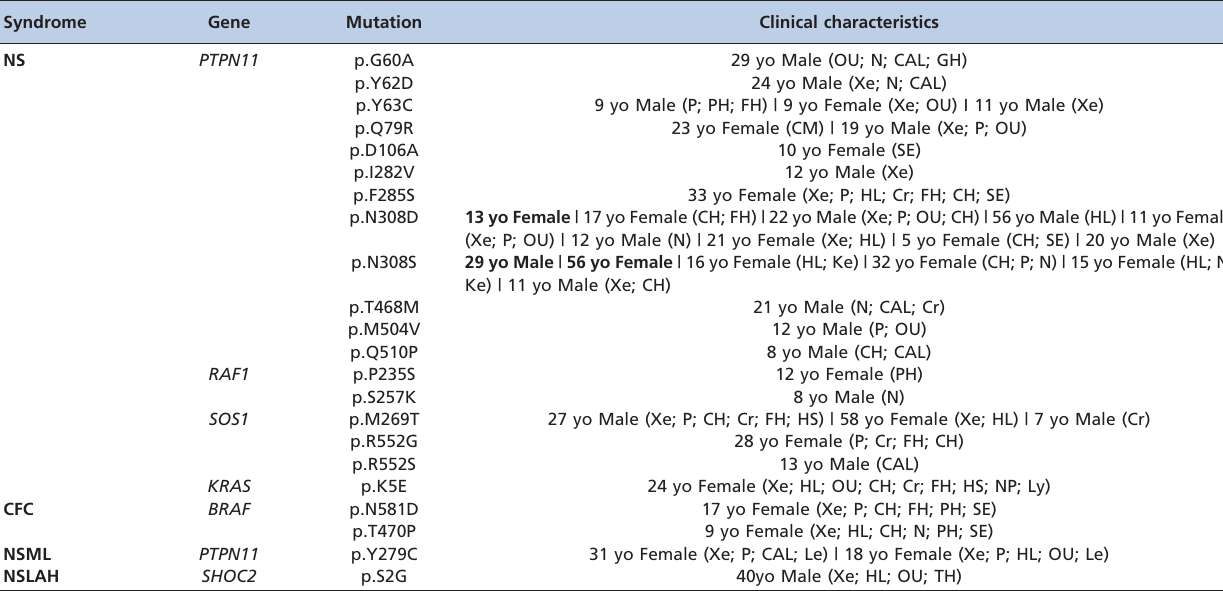
Table 1 - Genetic and clinical profiles of the 41 patients diagnosed with Noonan syndrome and Noonan-related syndromes. The syndrome column shows the clinical diagnosis of the patients; the gene column contains each gene; the mutation column contains the pathogenic alteration in the product of the genes; and the clinical characteristics column shows the most relevant clinical features of each patient, including age and gender, and tegumentary involvement is in brackets. Note that patients with no tegumentary involvement are indicated in